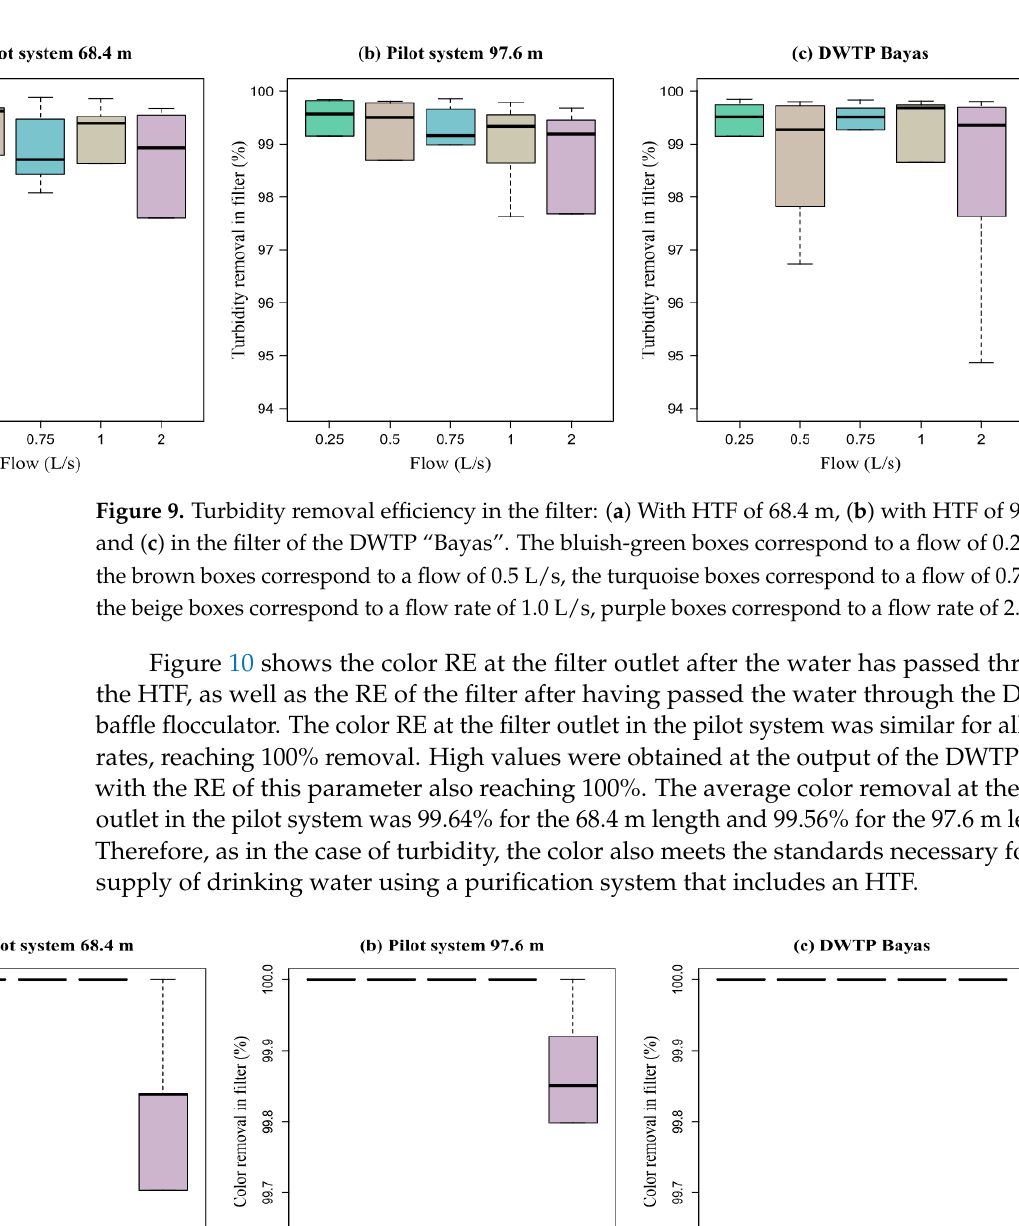
17 of 32 Figure 8. Color removal efficiency in the settler: ( a ) With HTF of 68.4 m, ( b ) with HTF of 97.6 m, and ( c ) in the filter of the DWTP “Bayas”. The bluish-green boxes correspond to a flow of 0.25 L/s, the brown boxes correspond to a flow of 0.5 L/s, the turquoise boxes correspond to a flow of 0.75 L/s, the beige boxes correspond to a flow rate of 1.0 L/s, purple boxes correspond to a flow rate of 2.0 L/s. 3.6.2. Impact of HTF on Turbidity and Color Removal Efficiency after the Filter Figure 9 shows how the turbidity RE at the filter outlet of the pilot system presents a similar behavior when the two lengths of the HTF were used for each tested flow rate. This RE can be compared with the efficiency of the conventional DWTP filter, due to the fact that REs greater than 99% have been achieved at all flow rates. For flow rates of 0.25, 0.5, 0.75, and 1 L/s and using the two lengths of the HTF, the average turbidity RE is greater than 98.7% in the pilot filtration unit. However, for the flow rate of 2 L/s, the av- erage RE in the two lengths of the pilot system was 97.88%, a relatively high efficiency